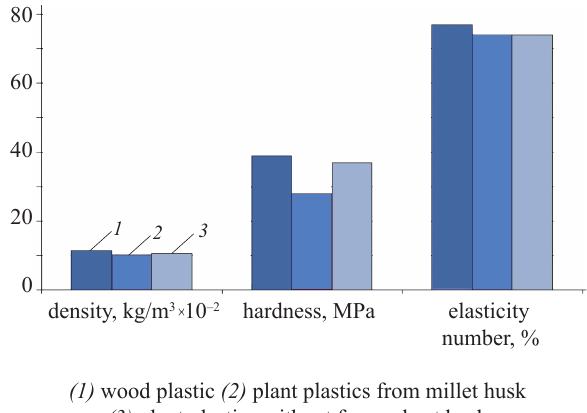
Figure 1 Average values of density, hardness, and elasticity number of plastics without